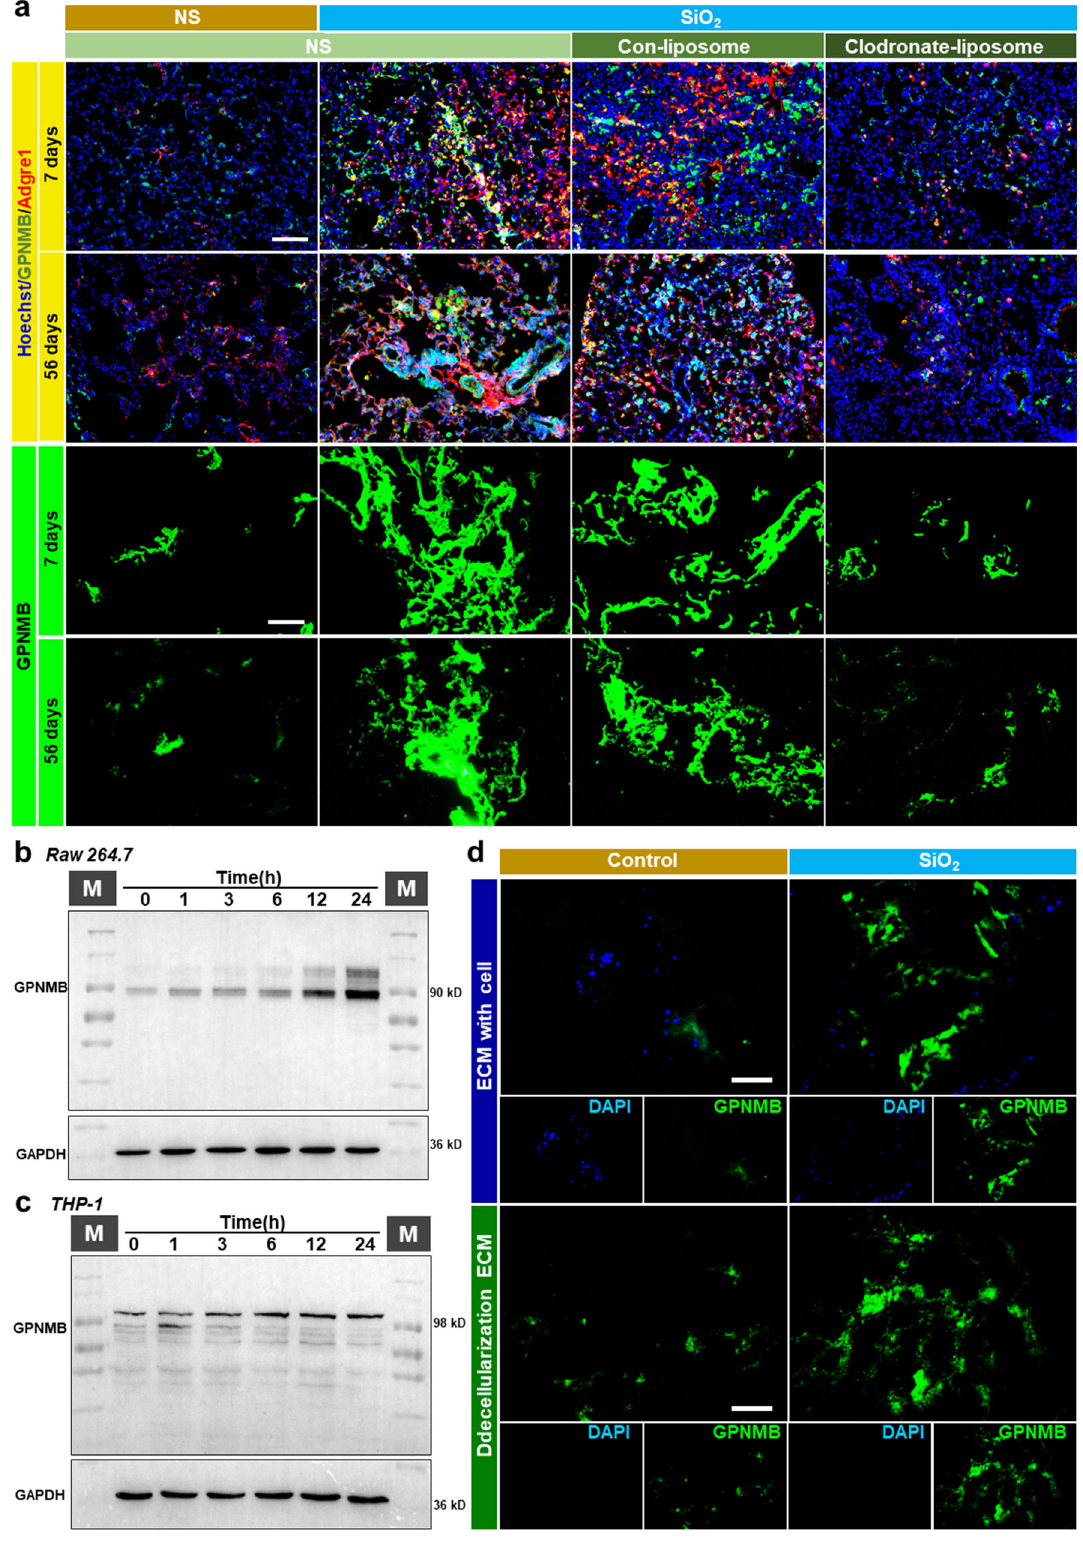
Fig. 6 GPNMB protein level was decreased in fi brotic ECM after macrophage depletion. a Immuno fl uorescence staining of macrophages and GPNMB in lung tissues from the four groups and GPNMB protein levels in ECM in the four groups; scale bar = 200 μ m. b , c GPNMB protein levels in Raw 264.7 and THP-1 cells after silica treatment; n ≥ 5 independent experiments. d Immuno fl uorescence staining of GPNMB in the ECM with or without Raw 264.7 cells; scale bar = 200 μ m. NS, normal saline; Adgre1, macrophage